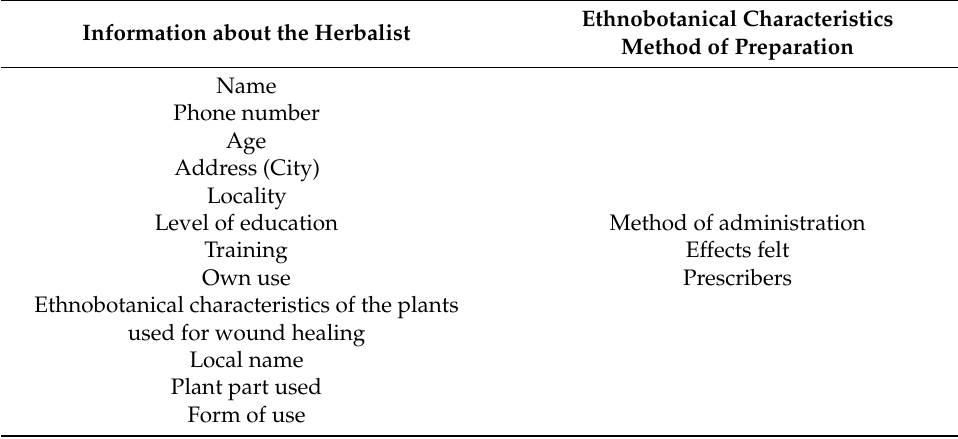
Table 1. Plants used for wound healing in traditional Moroccan pharmacopoeia. Information about the